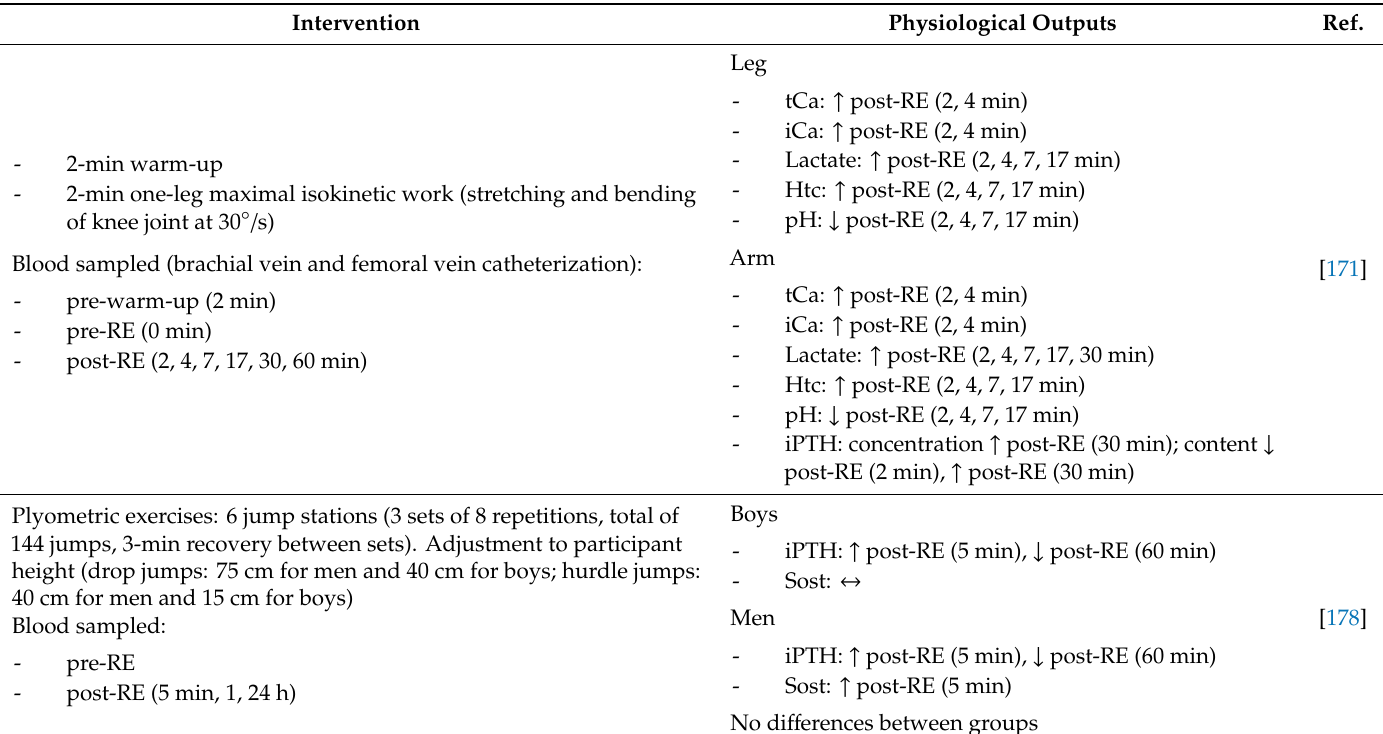
Plyometric exercises: 6 jump stations (3 sets of 8 repetitions, total